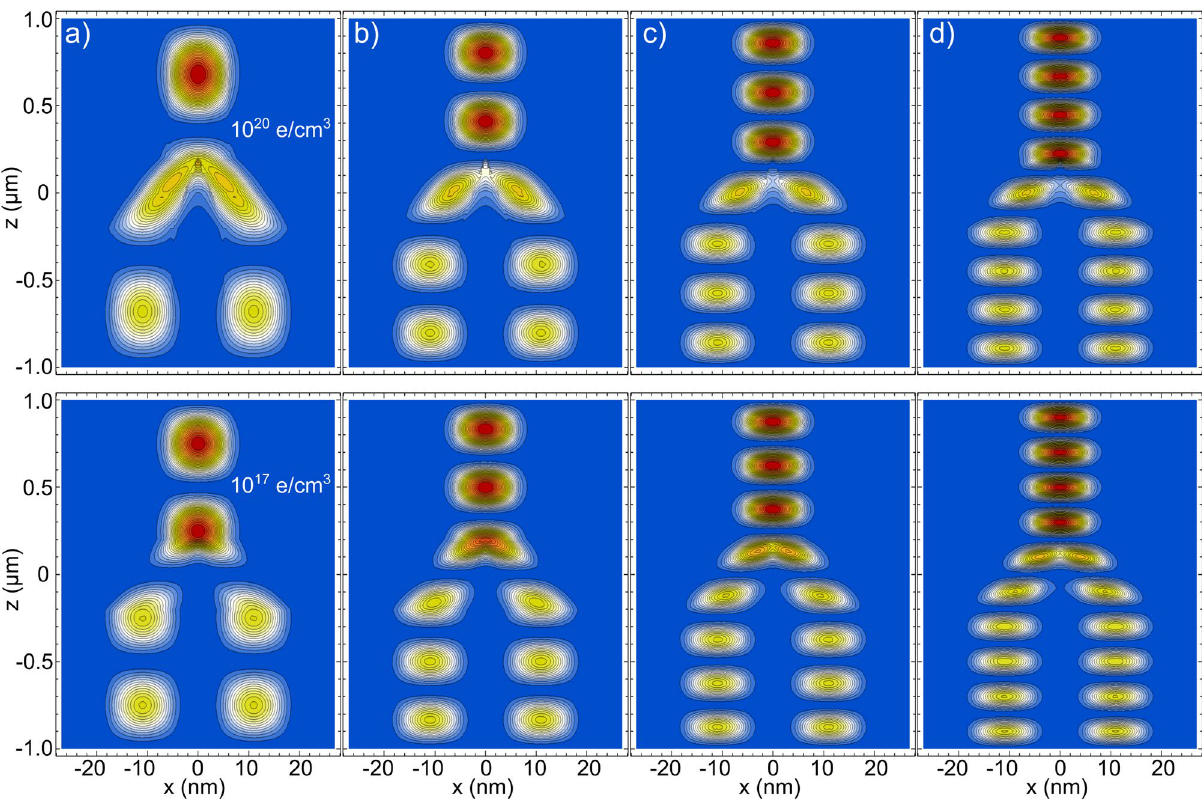
Figure 4. Electronic density probability corresponding to the ( a ) first-, ( b ) second-, ( c ) third- and ( d ) fourth- excited states for Y-junctions of L x , y = 12 nm, L b = 10 nm, and L z = 2 µ m. The top row corresponds to a density of 1 × 10 20 electrons/ cm 3 and the bottom row to a density of 1 × 10 17 electrons/ cm 3